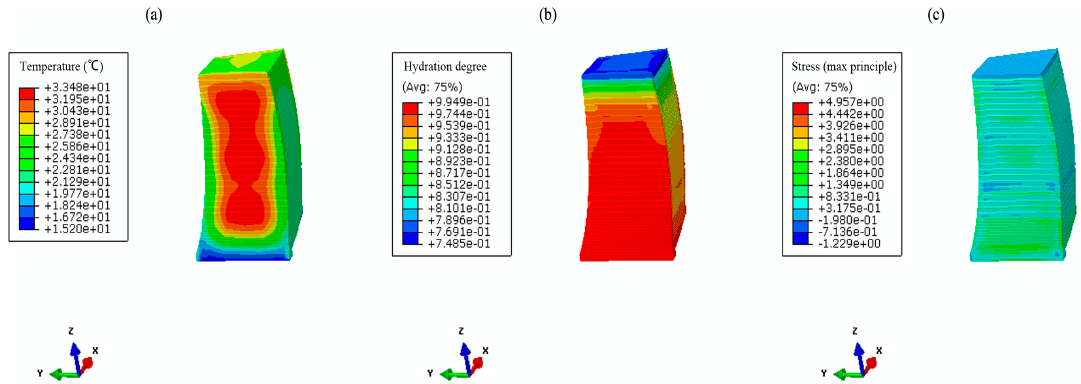
Figure 11. The coupled thermo-chemical-mechanical fields computations on 5 June 2013. ( a ) temperature (°C); ( b ) hydration degree (-); ( c ) first principle stress (MPa).